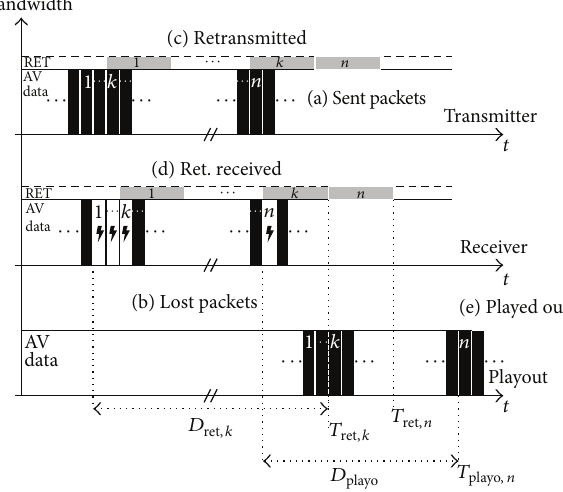
Figure 5: Interburst retransmission.